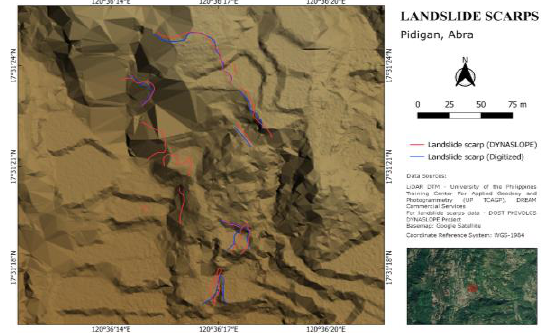
Figure 8 . Digitized scarps vs. Dynaslope